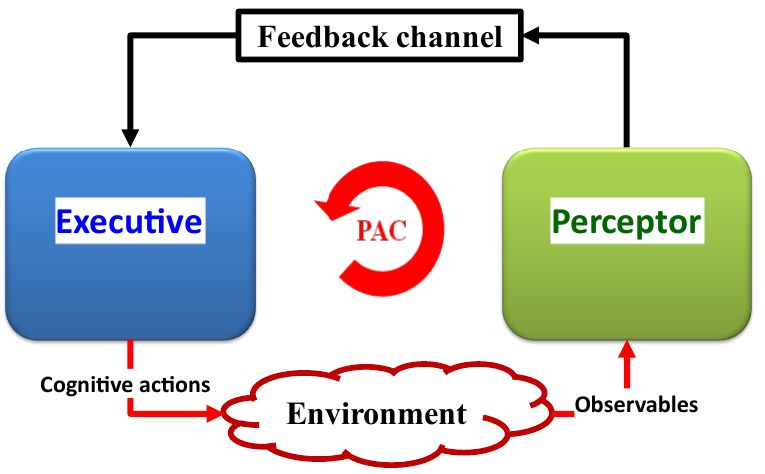
Figure 3. A basic cognitive dynamic system is shown in a block diagram.